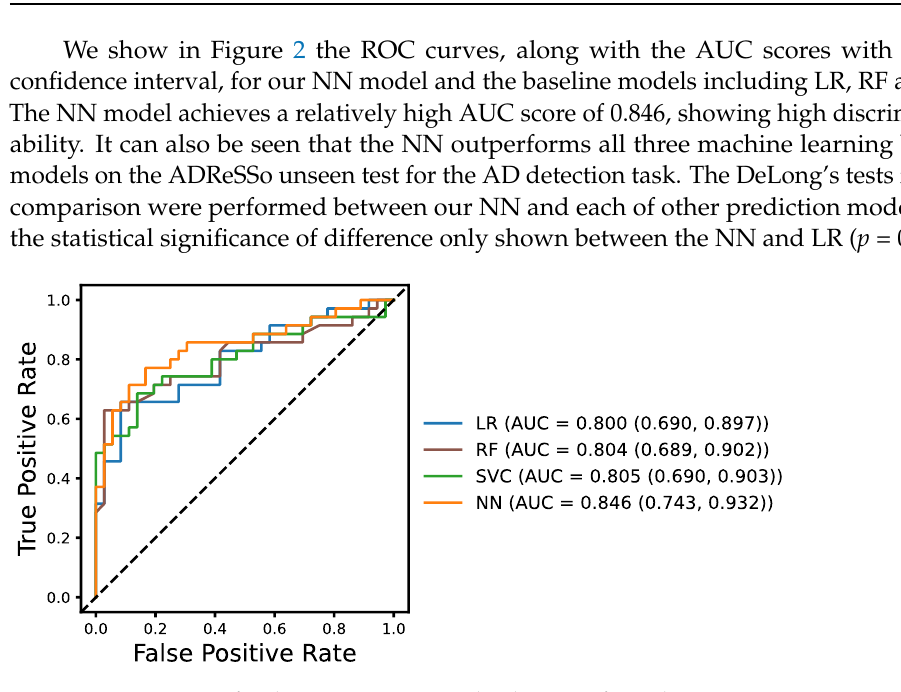
Figure 3. Model Performance for AD detection task using the data2vec embeddings from the ADReSSo unseen test data. The error bar in each metric denotes the 95% confidence interval. 3.2. Model Calibration In Figure 4, we show the calibration plot of the observed proportions and predicted probabilities of the five quantile groups for both the calibrated and uncalibrated NN. It can be seen from the figure that the level of agreement between the observed and pre- dicted groups matches well and a Hosmer-Lemeshow goodness-of-fit test shows that no significant difference exists between the observed proportions and predicted probabilities ( p > 0.05).